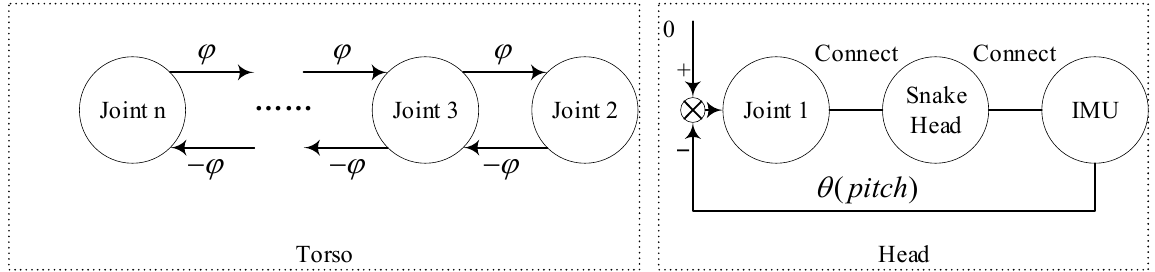
Figure 8. CPG network for controlling head navigation motion by IMU.